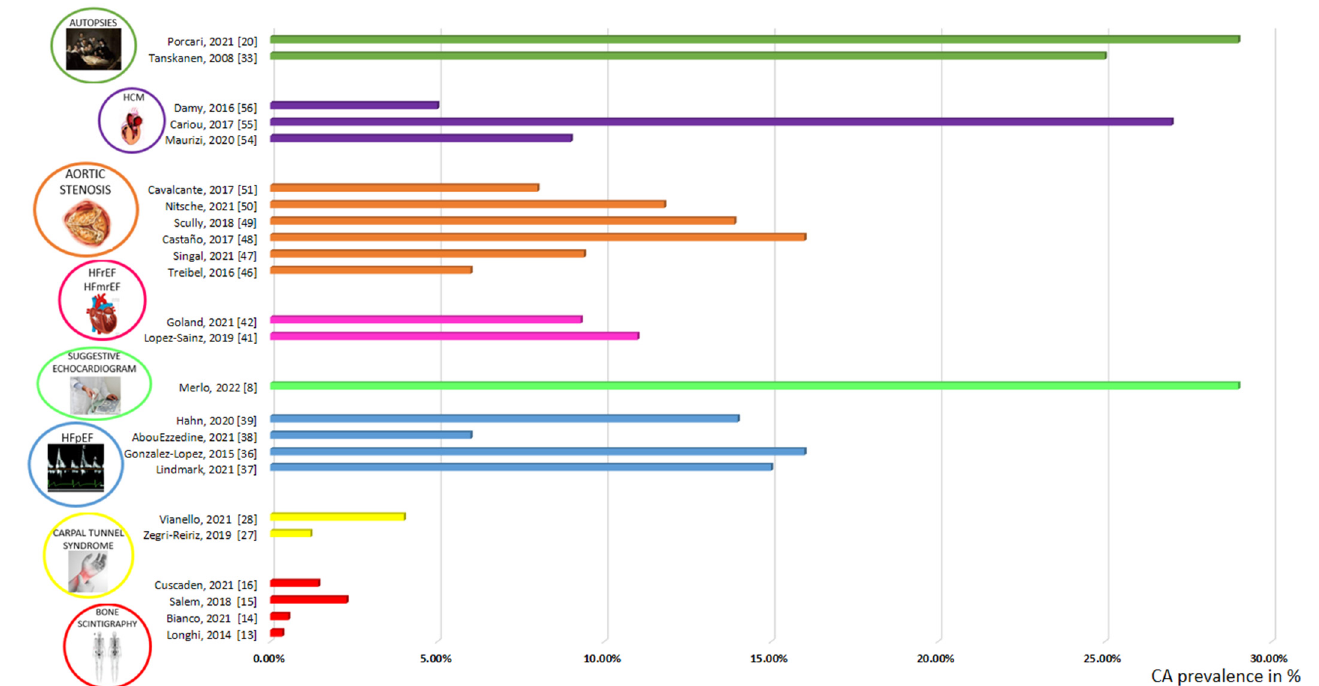
Figure 1. Prevalence of CA in different screening studies [8,13–16,20,27,28,33,36–39,41,42,46–51,54–56].